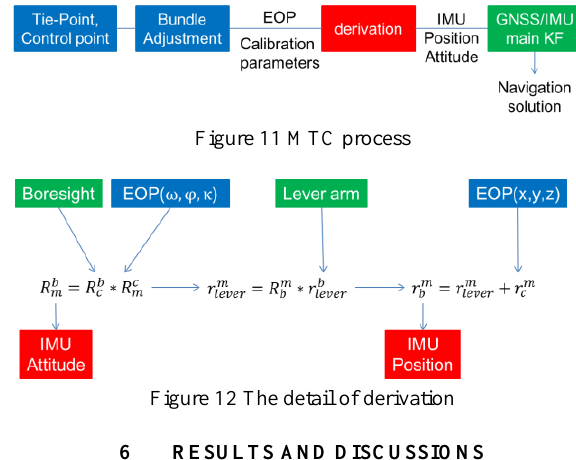
Figure 12 The detail of derivation